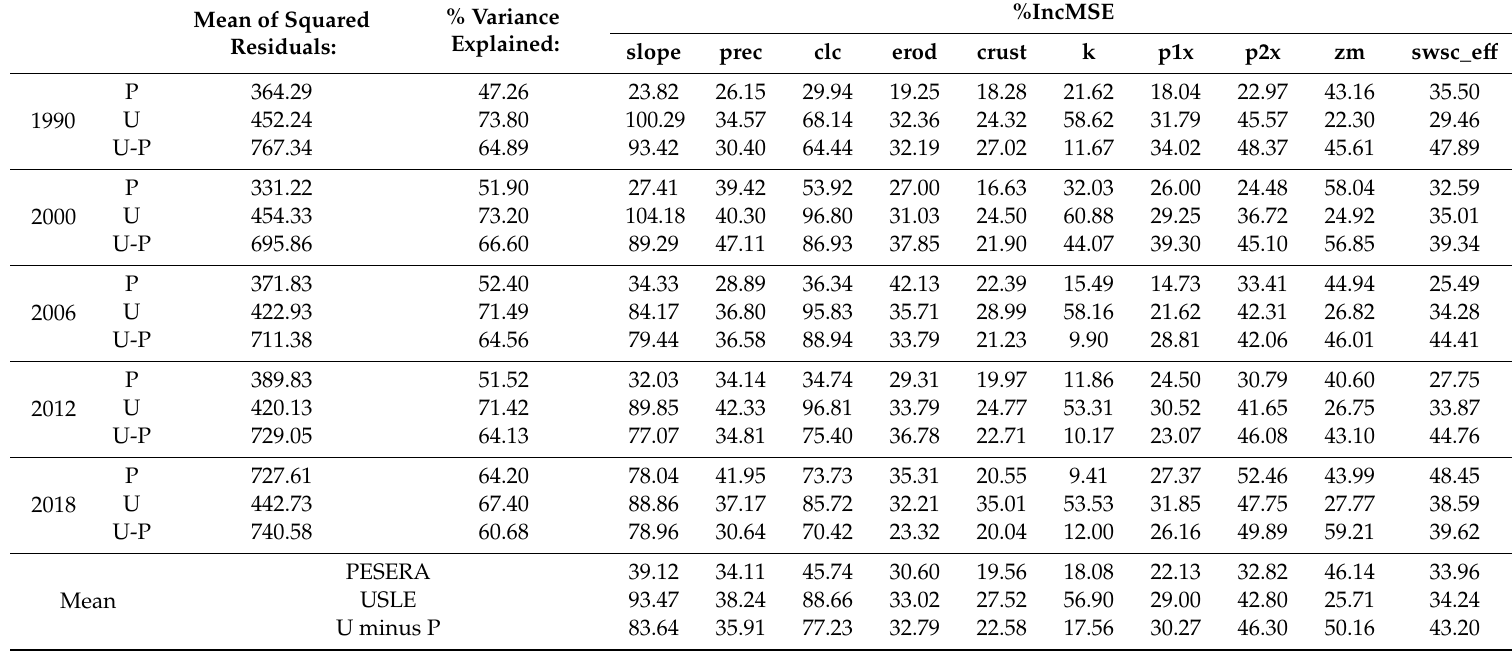
Table 7. Variable importance based on Random Forest regression